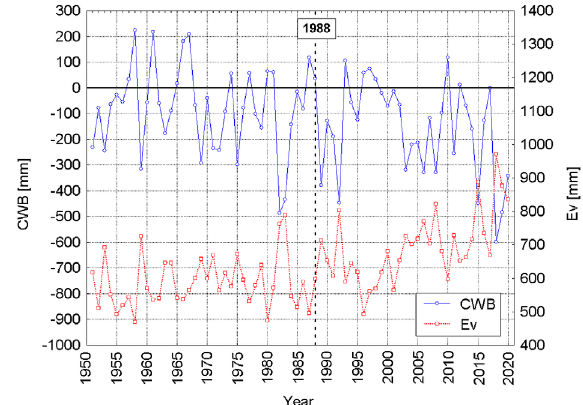
Fig. 13. The CWB in the calendar year (january– December) (CWB, unit: millimetre of water column) and the annual field evaporation (ev, unit: millimetre of water column) in Poznań in 1951–2020. The vertical dotted line marks the year when the climate regime changed (1988). CWB, climatic water